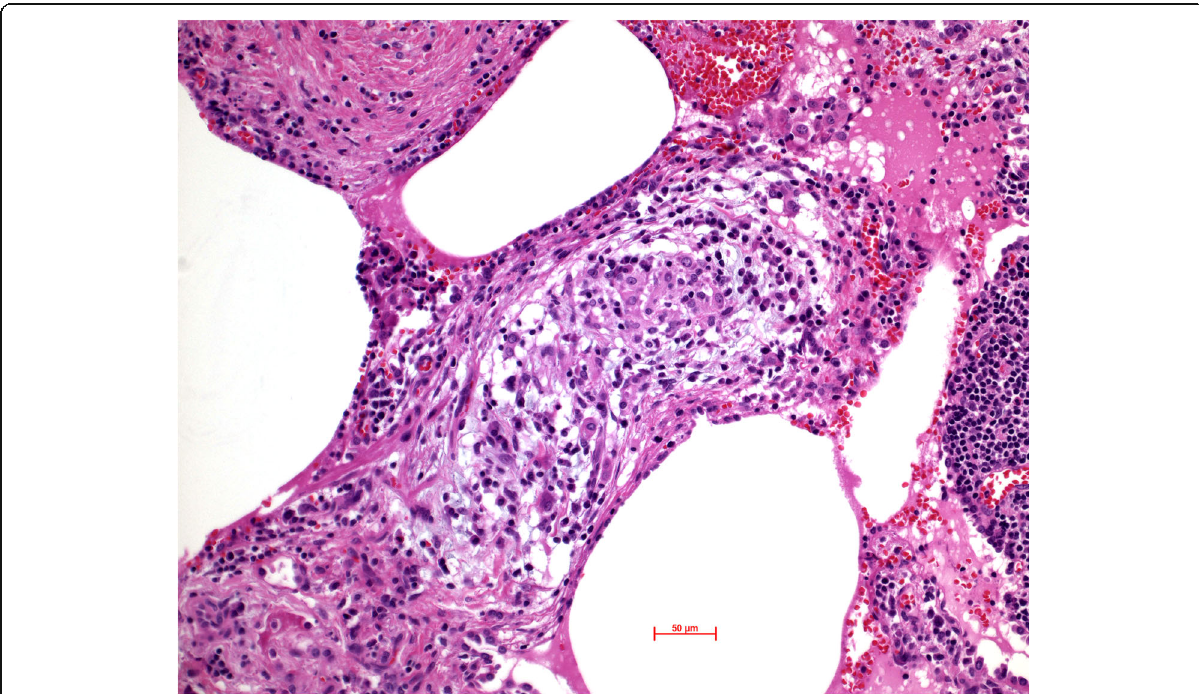
Fig. 14 Chronic rheumatoid arthritis, here with an epitheloid cell granuloma; the main differential diagnosis in such a case would by hypersensitivity pneumonia; stains for CD markers on lymphocytes will help in such a differential diagnosis. H&E, bar 50 μ m